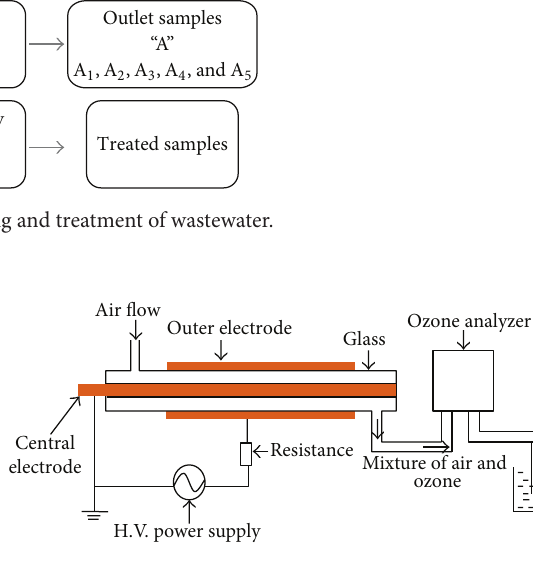
Figure 2: Experimental setup of DBD system for the ozone